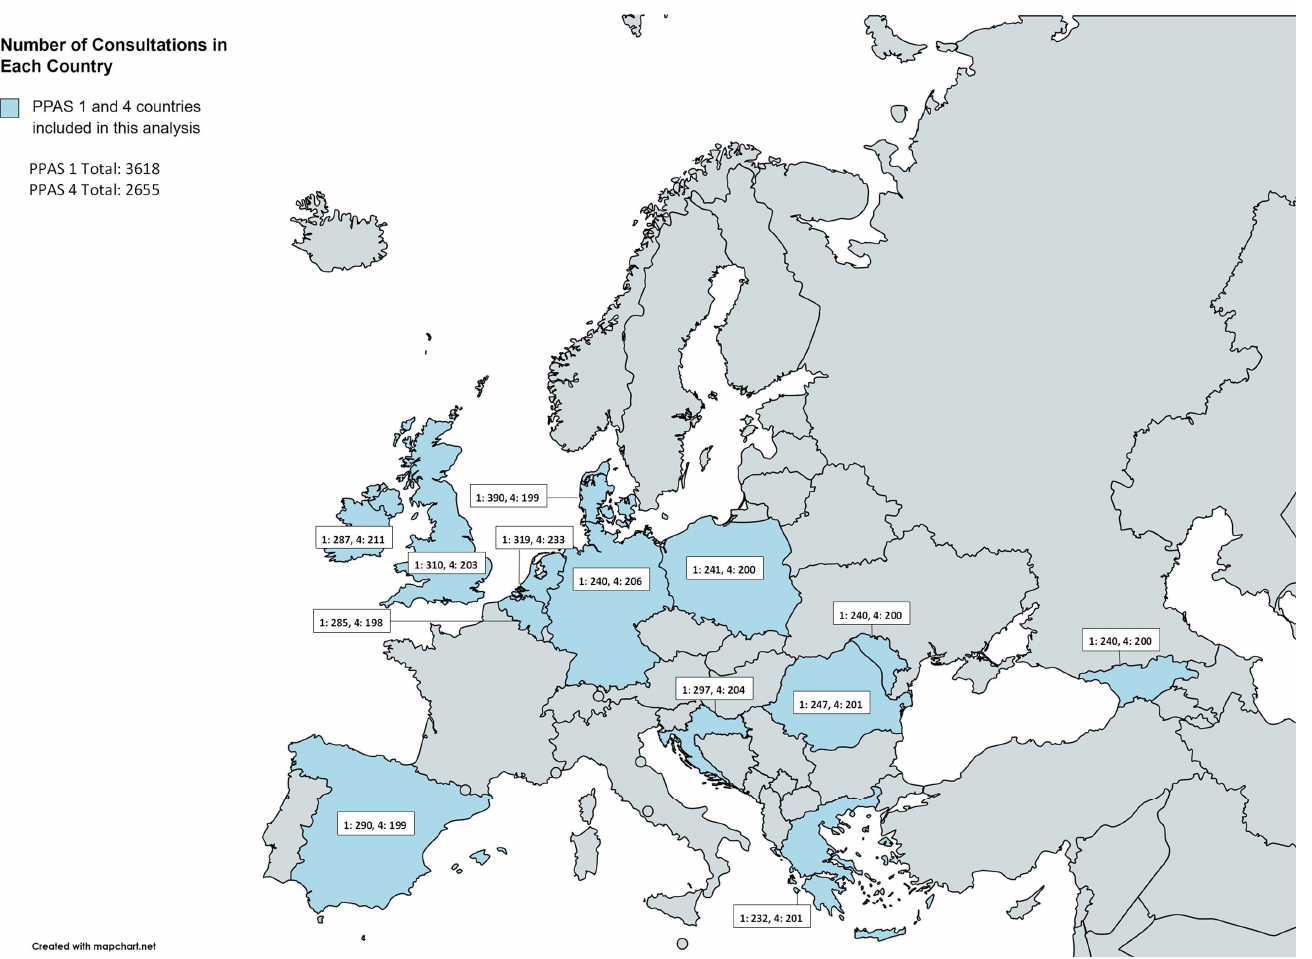
Figure 4. Number of consultations per participating country in PPAS-1 and -4.